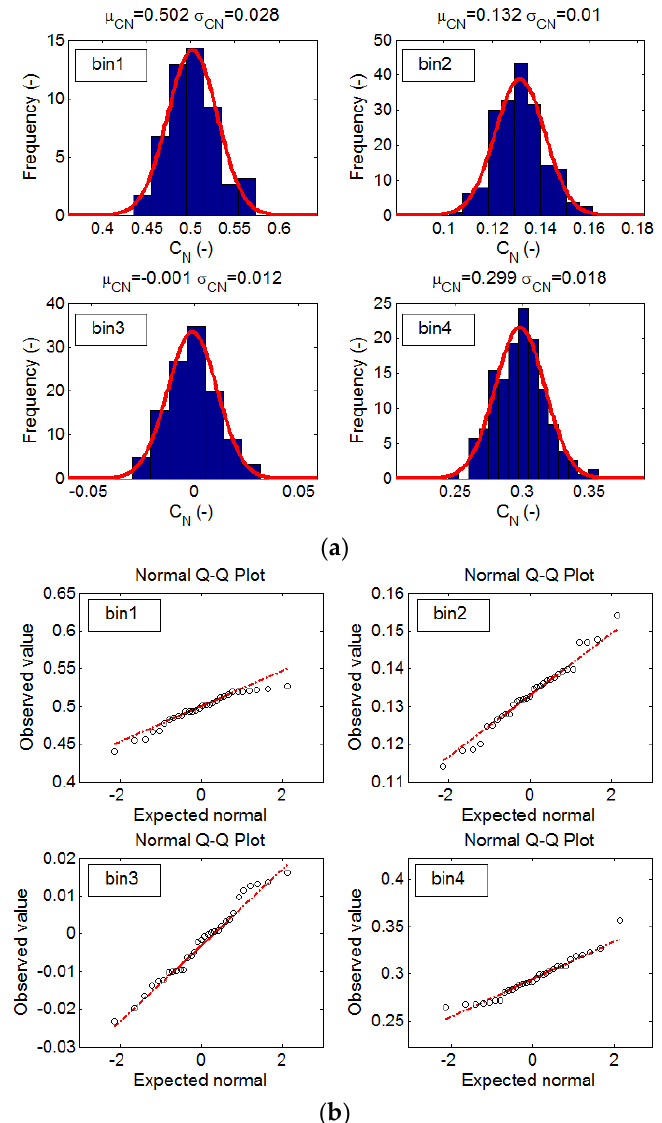
Figure 12. ( a ) Histogram, and ( b ) normal Quantile–Quantile of the normal force coefficients at U ∞ = 5 m/s and Φ = 30° at r/R = 0.30.